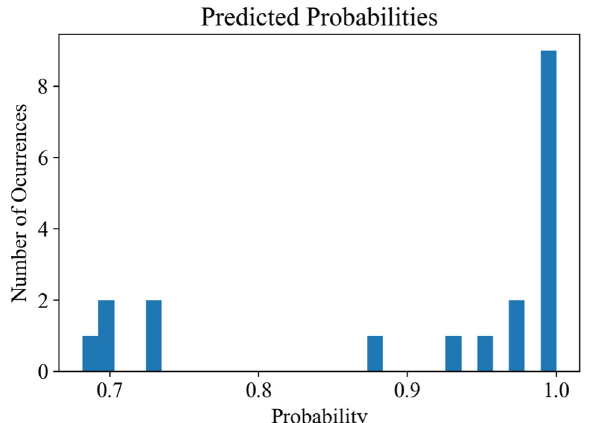
Fig. 12 Fitted GPR representing the failure probability for shear stress levels at 1.5% nominal strain.